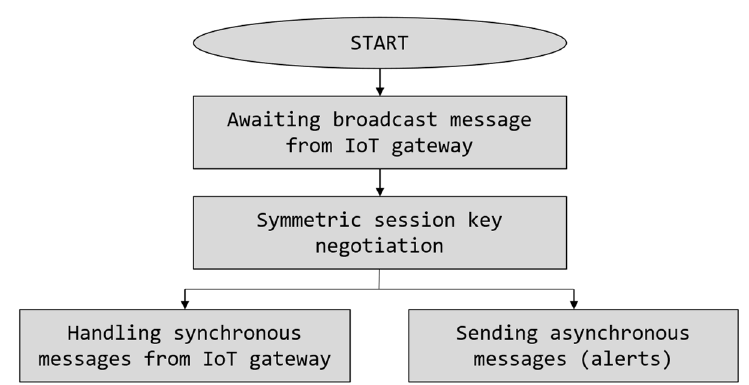
Figure 3. IoT device software operation in the IoT-Crypto system.